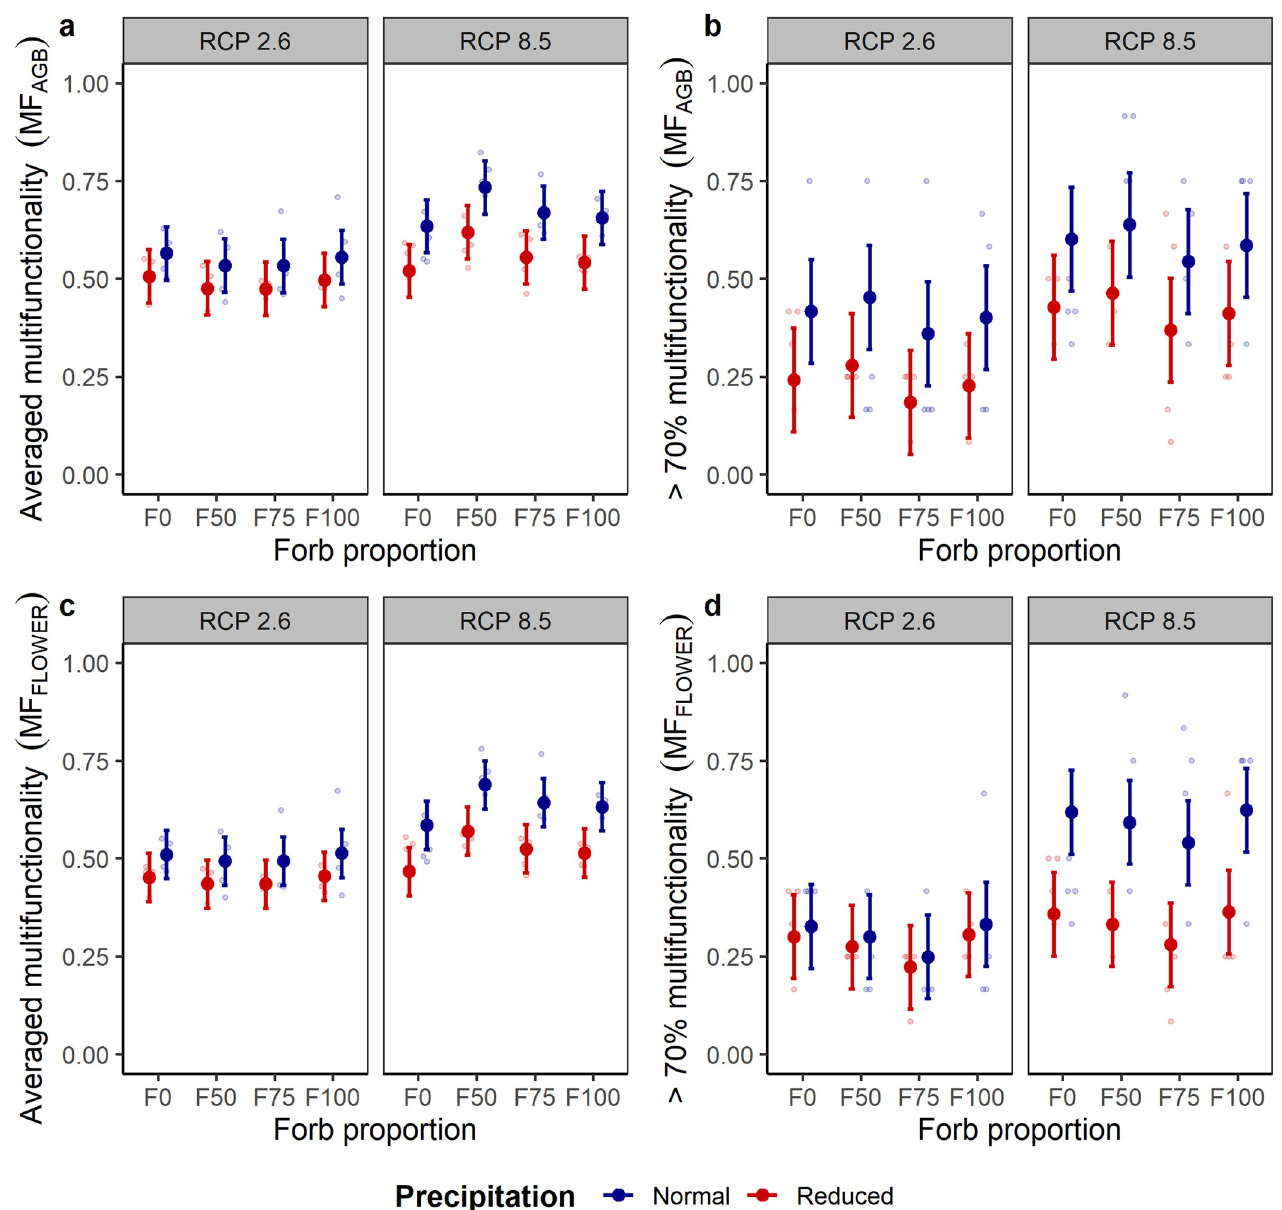
Fig 4. Effects of forb proportion, precipitation and climate change scenario on grassland multifunctionality. Two approaches to multifunctionality (MF) were calculated using eight indicator variables, including either aboveground biomass (a, b) or floral density (c, d) of mesocosm communities in the climate chambers of an ecotron facility. Averaged standardized values of the individual indicators contributed to averaged multifunctionality, whereas for the selected threshold, each function indicator exceeding 70% of the standardized maximum contributed to multifunctionality. Shown are means ± 95% confidence intervals. Data points are light-colored circles (n =